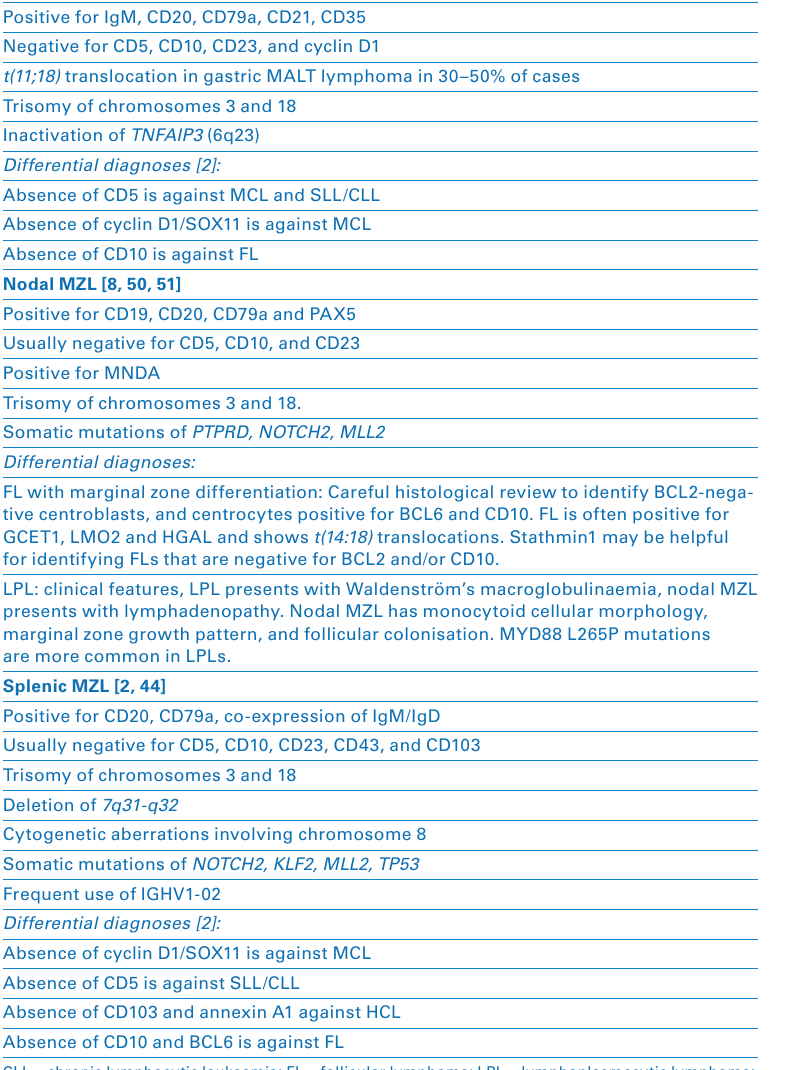
Table 2: Summary of immunophenotypic and cytogenetic findings in marginal zone B-cell lymphoma (MZL) including differential diagnoses [2, 8, 9, 14, 17, 50, 51, 85]. MALT lymphomas [18, 24, 87, 89, 97] Positive for IgM, CD20, CD79a, CD21, CD35 Negative for CD5, CD10, CD23, and cyclin